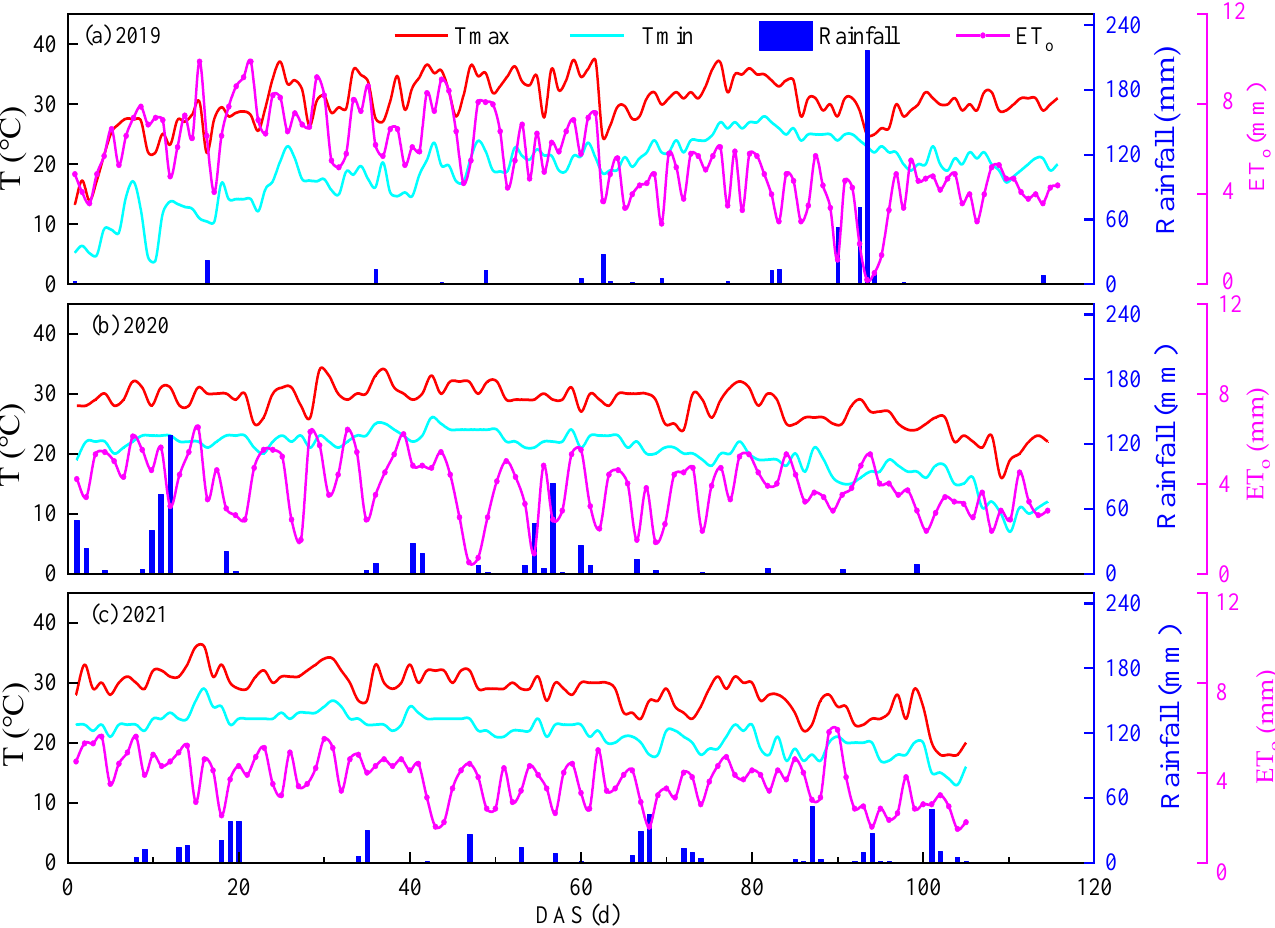
Figure 1. Meteorological data during the growth period of maize in 2019–2021. Tmax and Tmin are the maximum and minimum air temperature, respectively. ( a ) 2019, ( b ) 2020, ( c ) 2021